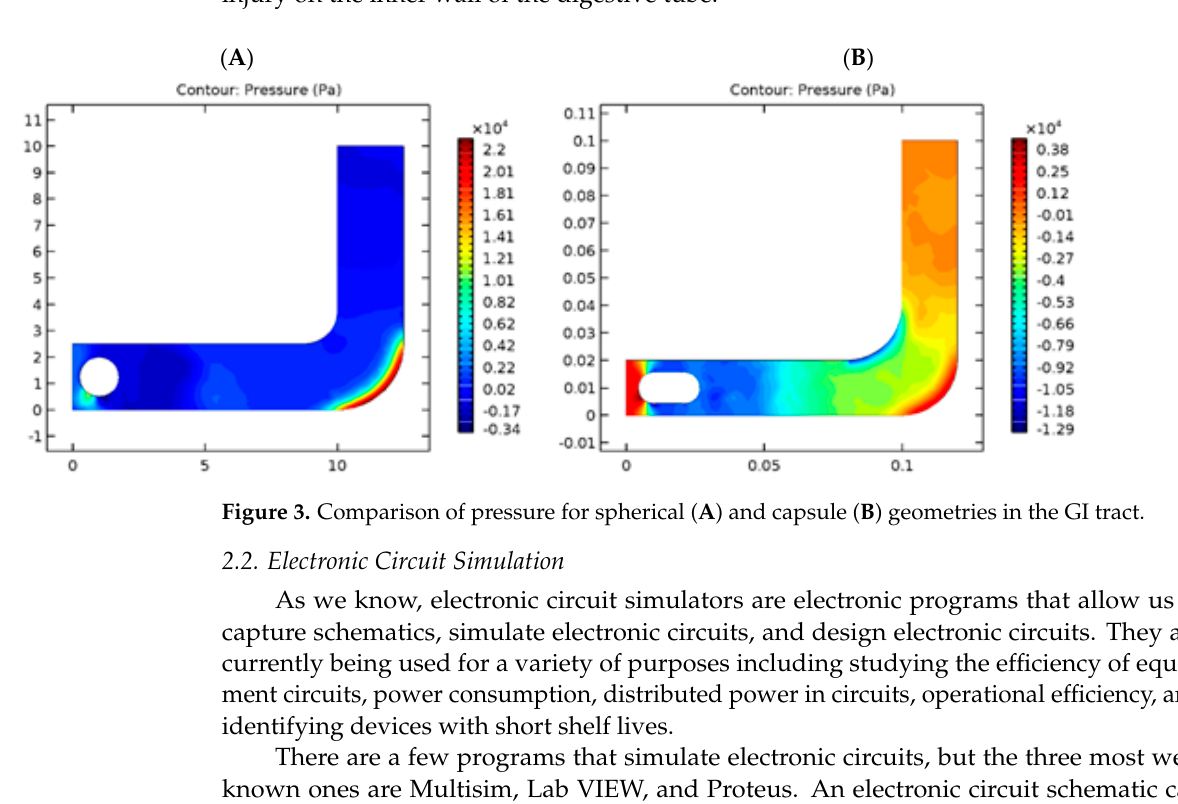
Figure 2. Comparison of velocity for spherical ( A ) and capsule ( B ) geometries in the GI tract.